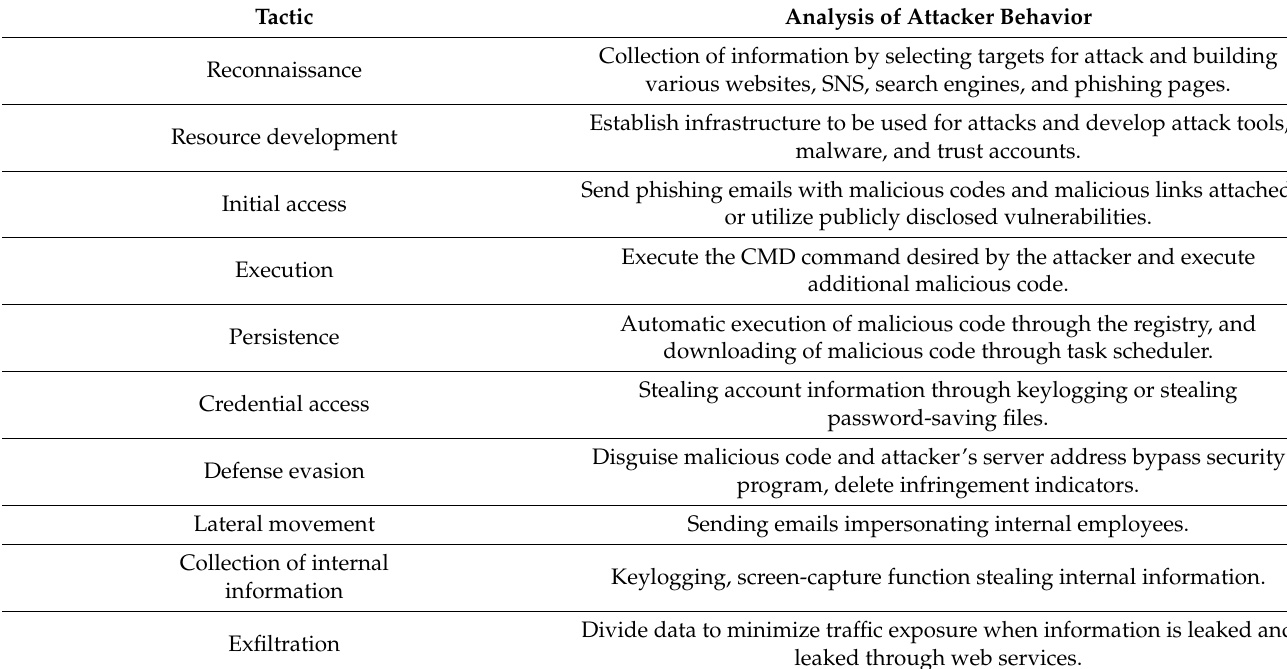
Table 3. Analysis of attacker behavior based on the MITRE ATT&CK framework. Tactic Analysis of Attacker Behavior Collection of information by selecting targets for attack and Reconnaissance